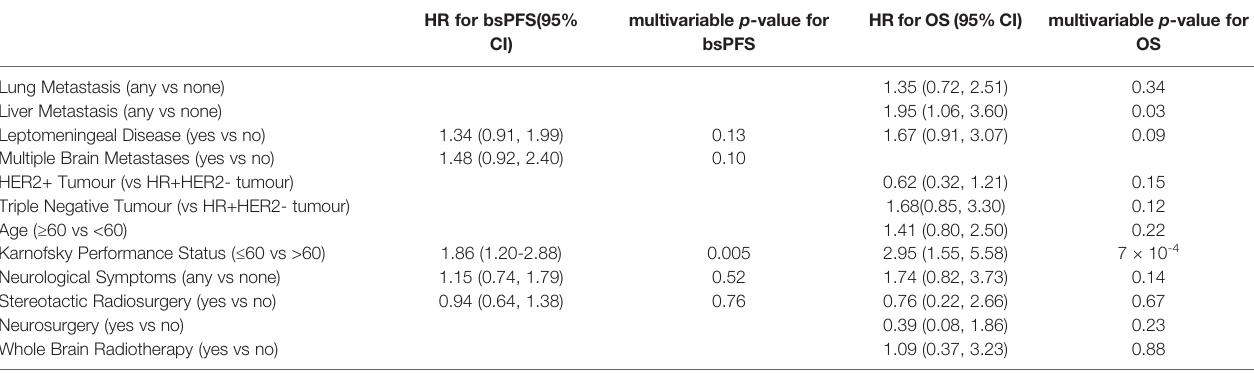
TABLE 3 | Results of multivariable data